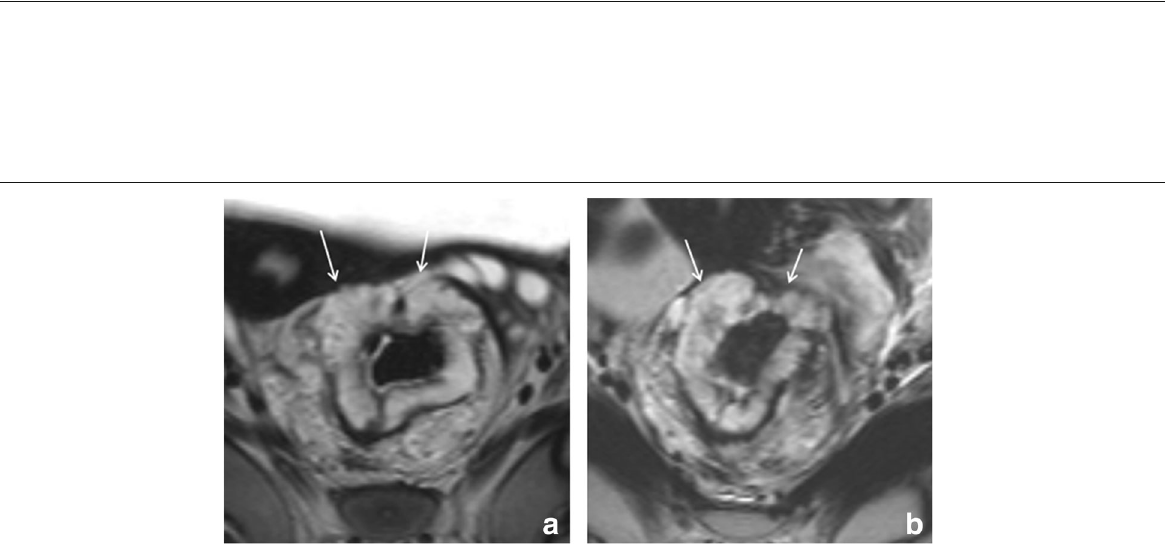
Fig. 5 Response assessment in mucinous type adenocarcinoma. Example of the pre- ( a ) and post-chemoradiotherapy ( b ) T2-weighted images of a young female patient with a mucinous type rectal adenocarcinoma. The tumor presents as a circular mass with distinctly high T2 signal intensity. Note the extensive MRF involvement anteriorly (arrows). The tumor has a close relation to the cervix but does not invade it macroscopically. After CRT, the volume and morphology of the mass is largely unchanged on MRI. On MRI, it is difficult to discriminate between sterilized mucin and mucin still containing viable tumor cells. Histopathology showed persistent ypT3N2